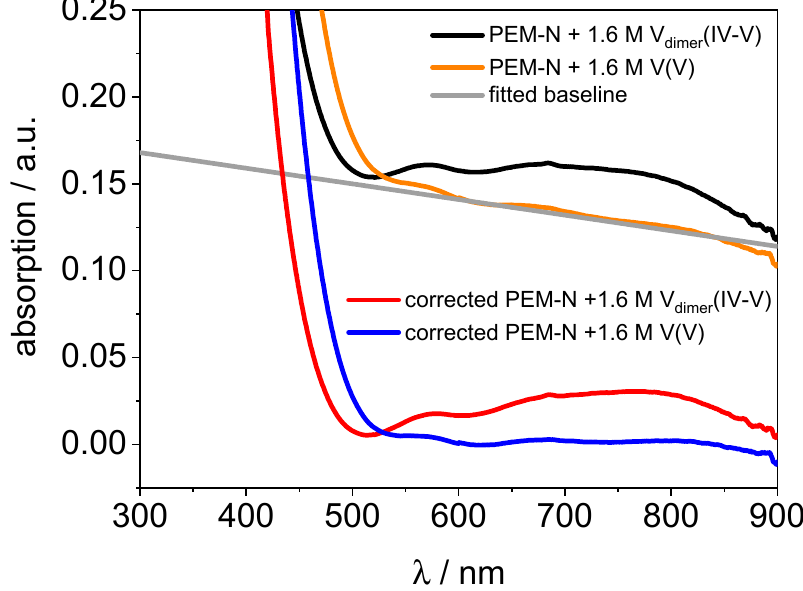
Figure 2. UV/VIS spectra of the PVDF-based membrane hydrated with 1.6 M V dimer (IV–V) and 1.6 M V(V) electrolyte and the baseline-corrected UV/VIS spectra are shown. A baseline, which was fitted to the UV/VIS spectrum of the PVDF-based membrane hydrated with 1.6 M V(V) electrolyte in the range 550 nm to 900 nm, is indicated.